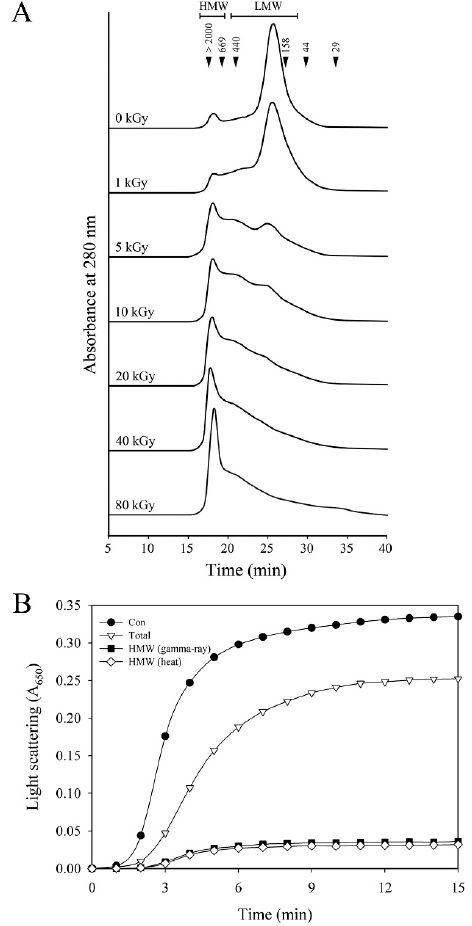
Figure 3. ( A ) SEC profiles of non-irradiated and irradiated AtTDX proteins. The numbers in the